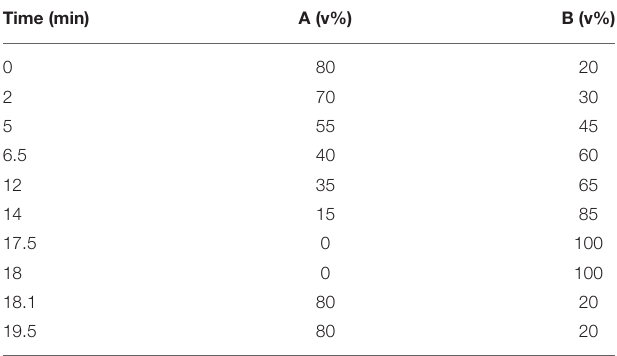
TABLE 1 | The gradient conditions for reversed phase C 18 separation for lipids.